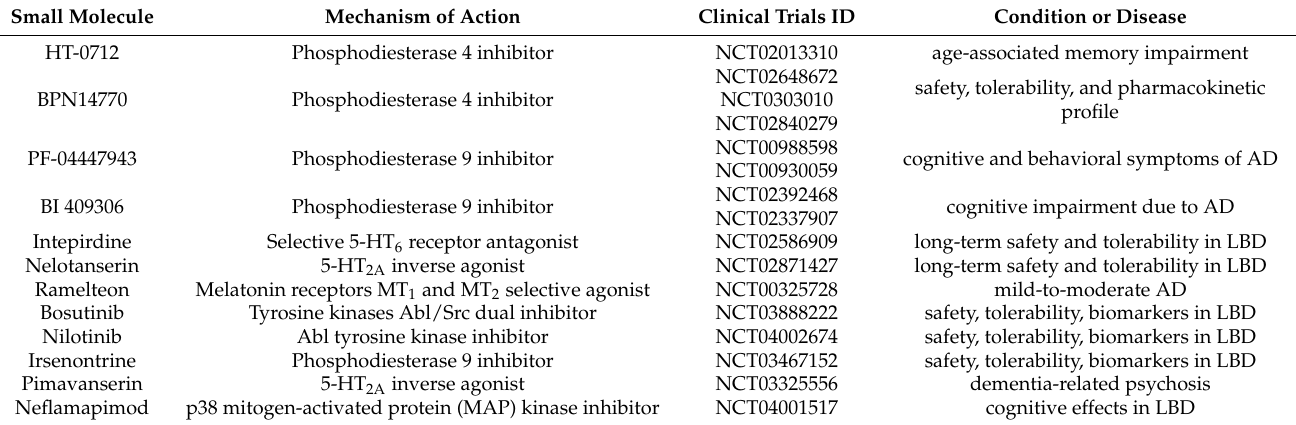
Table 3. The representatives of clinical trials of new small molecules targeting